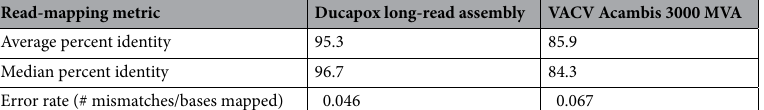
Table 2. Read alignment identity and error metrics of exclusive viral read set to the long-read assembly and to VACV Acambis 3000